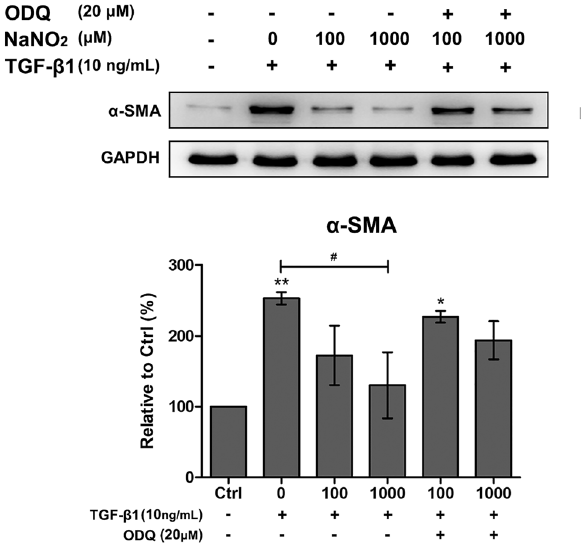
Figure 8. Evaluation of cGMP dependent pathway using guanylate cyclase inhibitor, ODQ (20 μM), in TGFβ1 (10 ng/mL) stimulated keratocyted. Addition of ODQ eliminated the anti-myofibroblastic effect of NO donors (DETA NONOates and sodium nitrite) as demonstrated by the restored α-SMA expression . Statistical significance was determined using one-way ANOVA followed by the Bonferroni multiple comparison test and the significant difference compared to no treated control ( * p < 0.05, **p < 0.01); # significant difference compared to TGFβ1 treated group ( # p < 0.05).